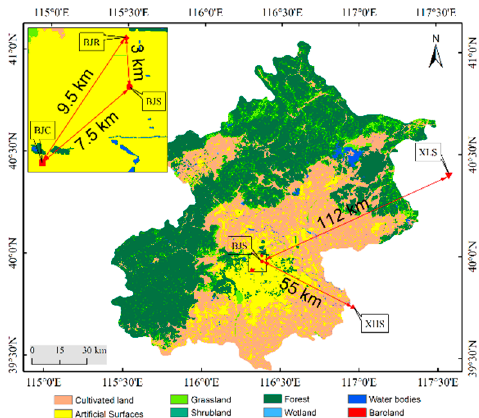
Figure 1. Geographical information regarding the AERONET (Aerosol Robotic Network) stations in Beijing and its surrounding areas. BJS: Beijing site, BJC: Beijing_CAMS site, BJR: Beijing_RADI site, XHS: Xianghe site, and XLS: Xinglong site.